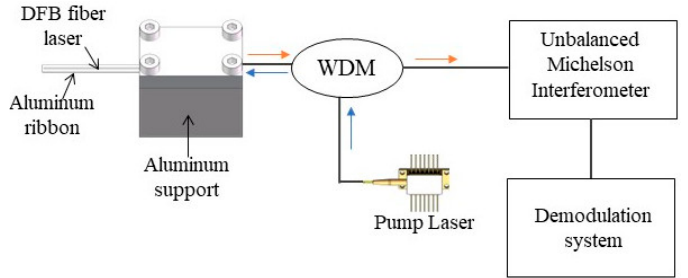
Figure 1. The schematic of the sensor system. The vector sensor operates on the principle of cantilever deflection by fluid